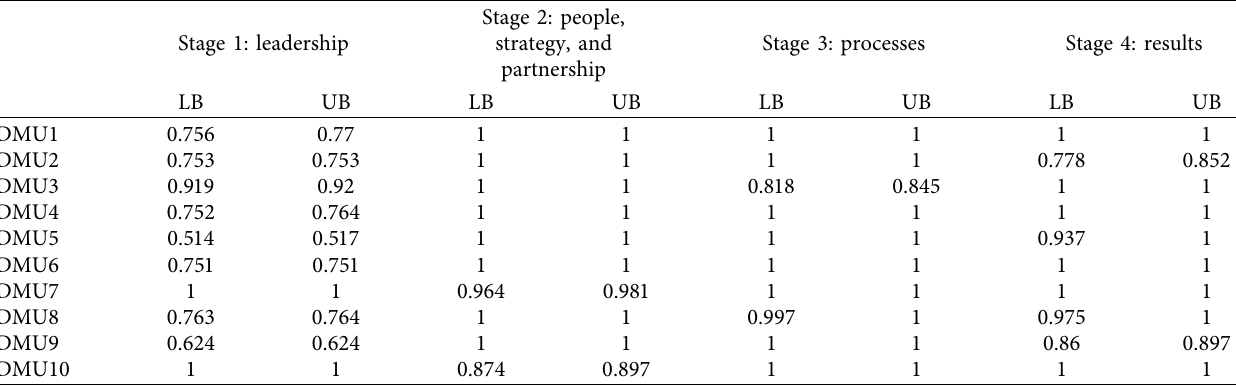
Table 7: The efficiency of EFQM stages at α �